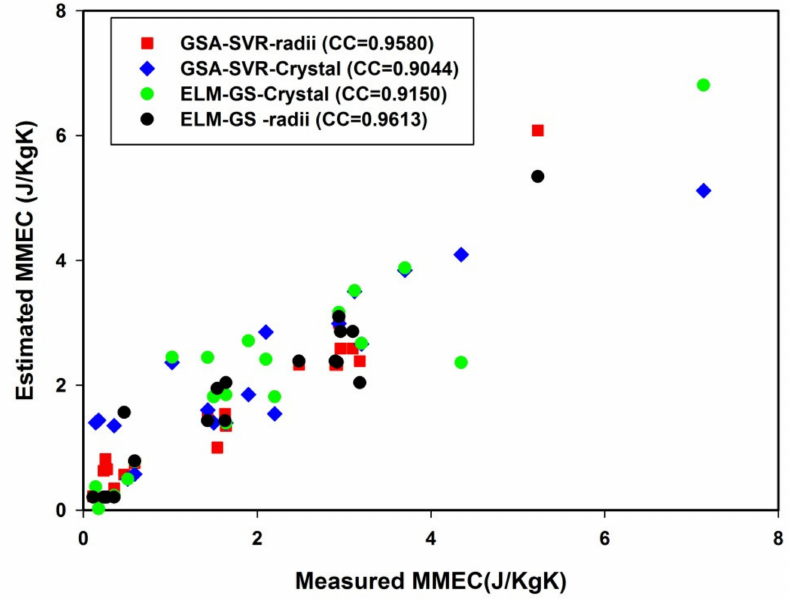
Figure 10. Correlation cross-plot between the measured and estimated MMEC for all developed models using the testing set of